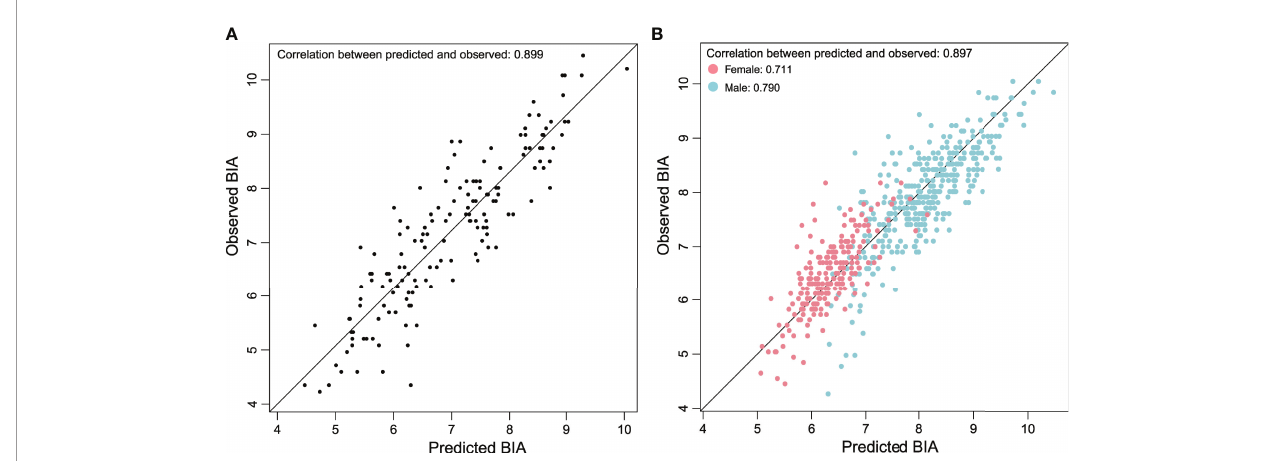
FIGURE 2 | (A) Relationship between BIA derived from T12-ESA and observed BIA in the validation group composed of 152 cases. (B) Relationship between BIA derived from T12-ESA and observed BIA in all cases strati fi ed by sex.